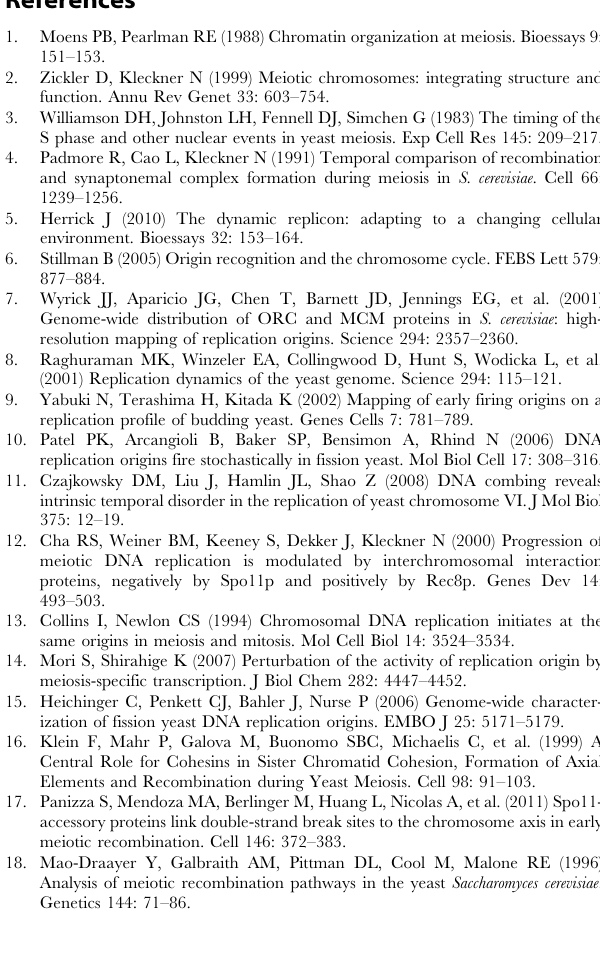
Table S1 Mcm2-7 binding sites identified in this study. Table S2 Mitosis- and meiosis-specific Mcm2-7 binding sites. Table S3 Axis sites identified in this study. Table S4 Strains used in this study. Table S5 Smoothed predicted profiles used in this